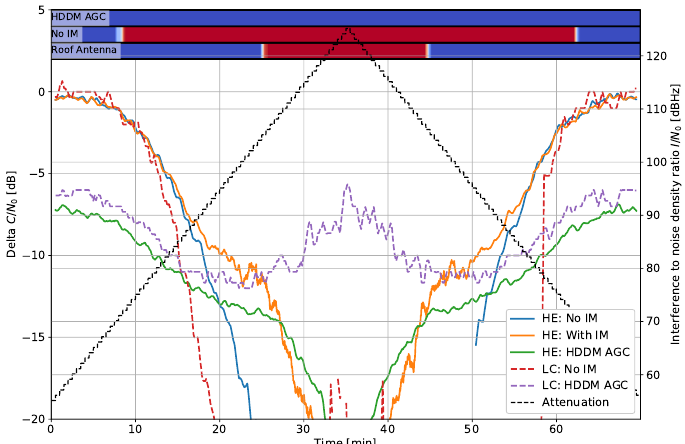
Figure 12. Interference #9: Delta C / N 0 for pulsed noise with 100 µs pulse width and 35 MHz